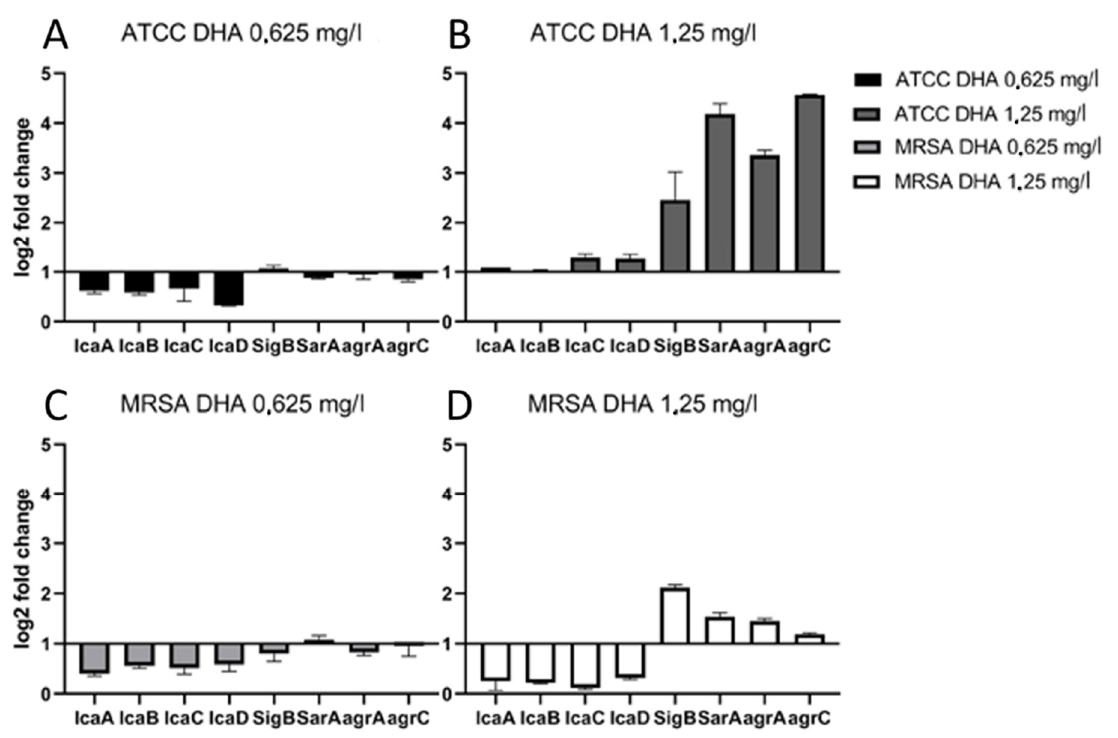
Figure 1. Results of icaADBC, SigB, SarA, and agrAC gene expression for biofilm produced at 0.625 mg/L DHA and 1.25 mg/L DHA by Staphylococcus aureus ATCC 29213 ( A , B ) and a clinical MRSA isolate ( C , D ). The results for the comparison between different DHA concentrations and their controls were analyzed by calculation of delta-delta ct values with each standard deviation.